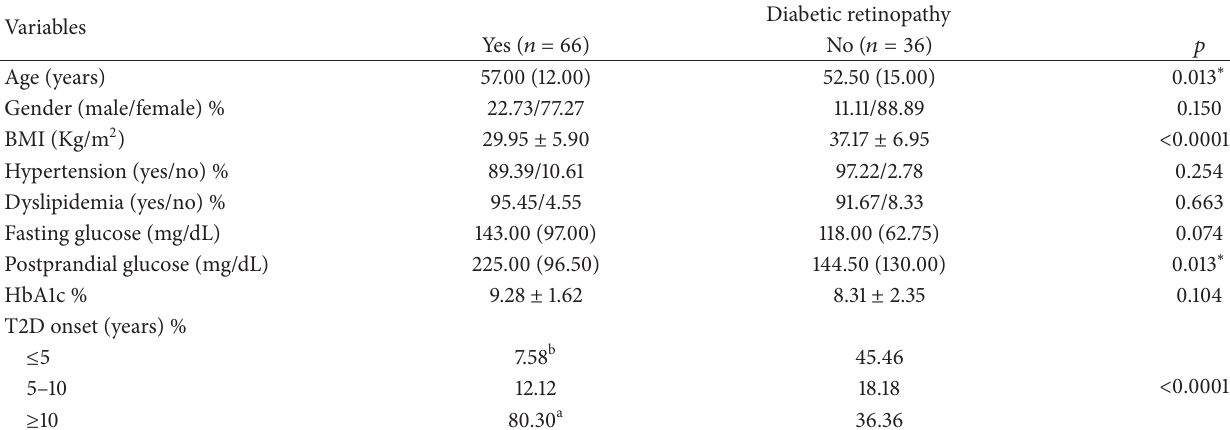
Table 1: Clinical and laboratorial characteristics in T2D patients considering retinopathy